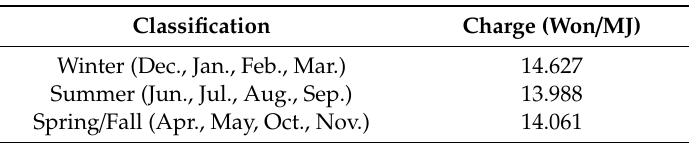
Table 6. Gas charge sections for industrial